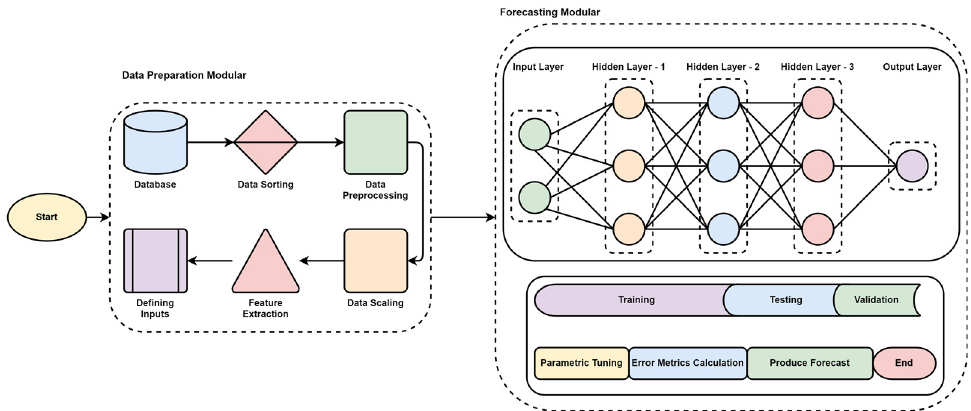
Figure 10. ANN methodology for the experimental framework.